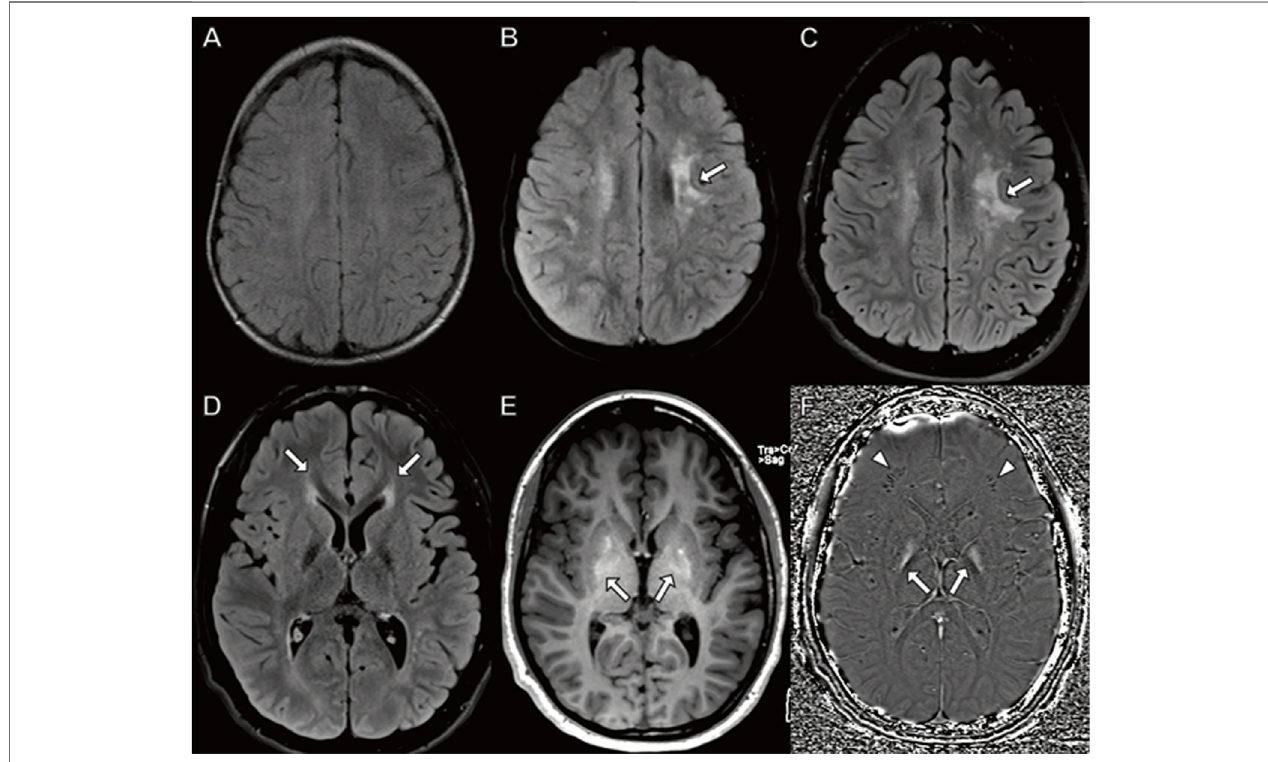
FIGURE 4 | Brain MRI in a boy with CYP2U1 mutation. (A – C) Axial fl uid-attenuated inversion recovery images at (A) 3 years (B) 9 years, and (C) 15 years demonstrate worsening, patchy hyperintense signal in the centrum semiovale involving subcortical U fi bers ( (B,C) arrows). (D – F) MRI at 15 years with (D) abnormal hyperintense signal extending from the frontal horns of the lateral ventricles reminiscent of the “ ear of the lynx ” sign (arrows). (E) Abnormal signal hyperintensity in the globus pallidus on axial T1-weighted images corresponding to (F) hyperintense signal on axial susceptibility-weighted phase image (arrows) indicating mineralization. (F) Linear hypointense signal in the frontal white matter representing calci fi cations in a perivenular distribution (arrowheads).